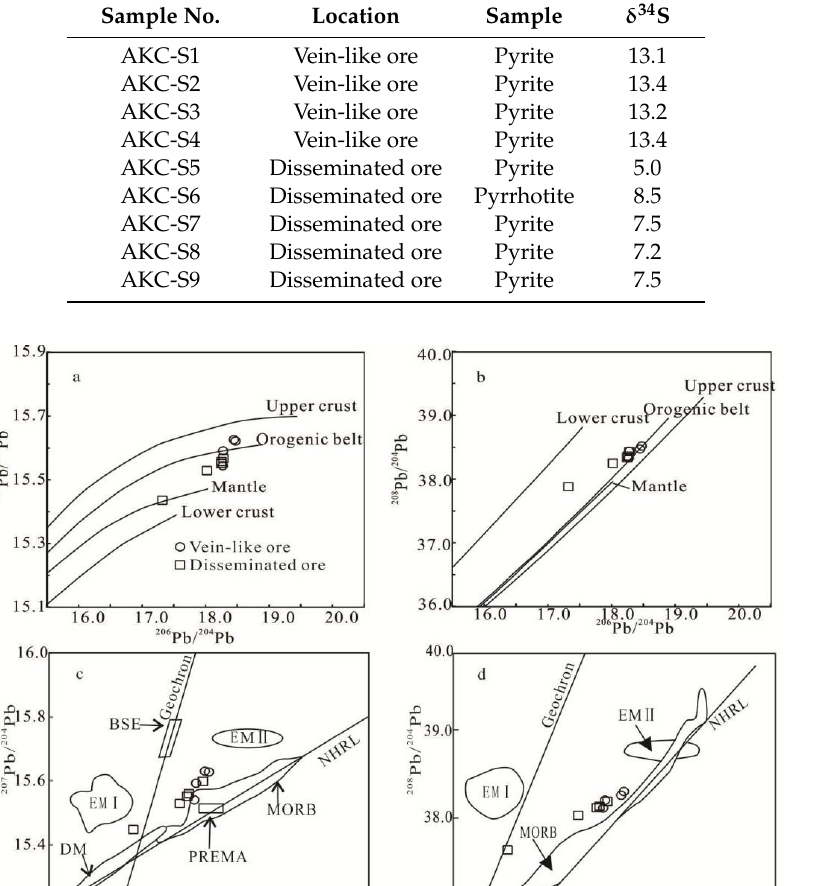
Figure 7. ε Hf (t) versus time (Ma) diagram for gabbro in Akechukesai Ⅳ mafic–ultramafic complex. Data sources for 1.8Ga, 2.5 Ga, and 3.0Ga lines are from Wu et al. [23]. Gray shadow areas are from Li et al. [6] and a compilation of literature data. Figure 8. Histogram of S isotopic composition of sulfides from vein-like ore and disseminated ore. Table 4. S isotopic composition of the sulfides from the No.IV mafic -ultramafic complex. Sample No.